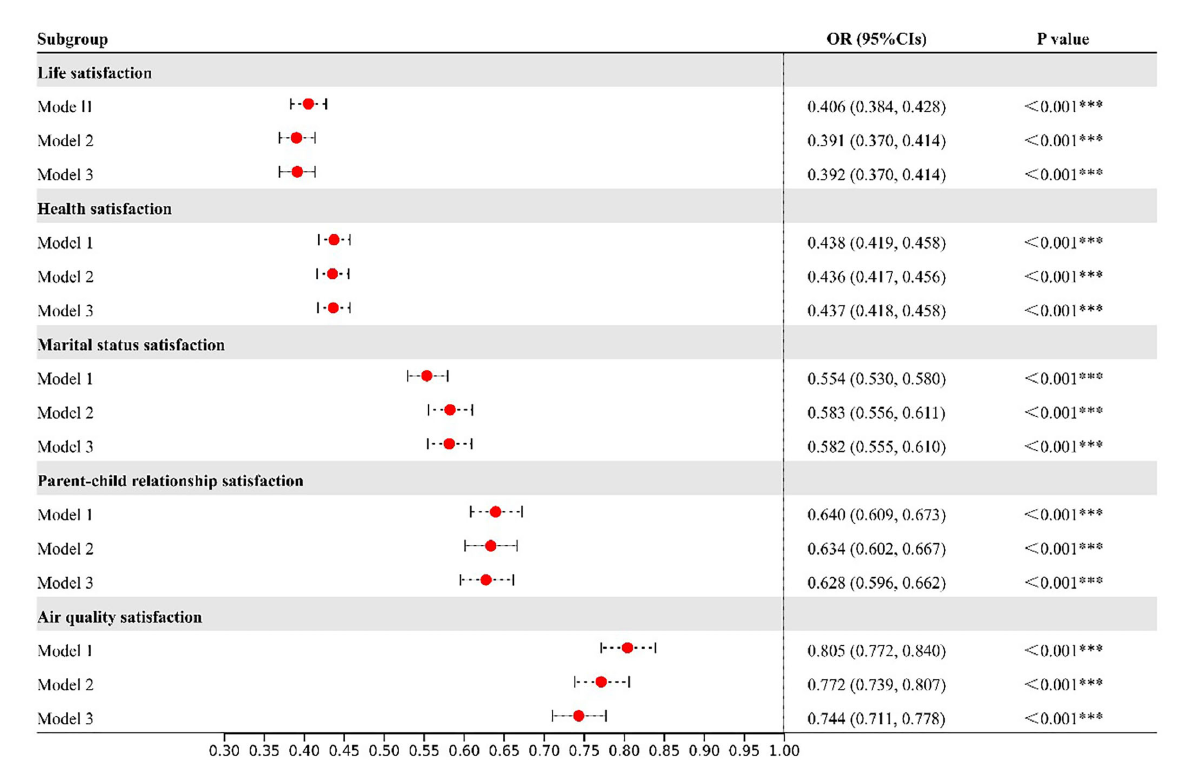
FIGURE3 Associations between each 1-point increase in satisfaction and the odds ratio (with 95% confidence intervals (CIs)) of depressive symptoms. Model 1: Crude model. Model 2: Adjusted for age, gender, educational level, and marital status. Model 3: Adjusted for age, gender, educational level, marital status, smoking status, drinking status, residence, and regional